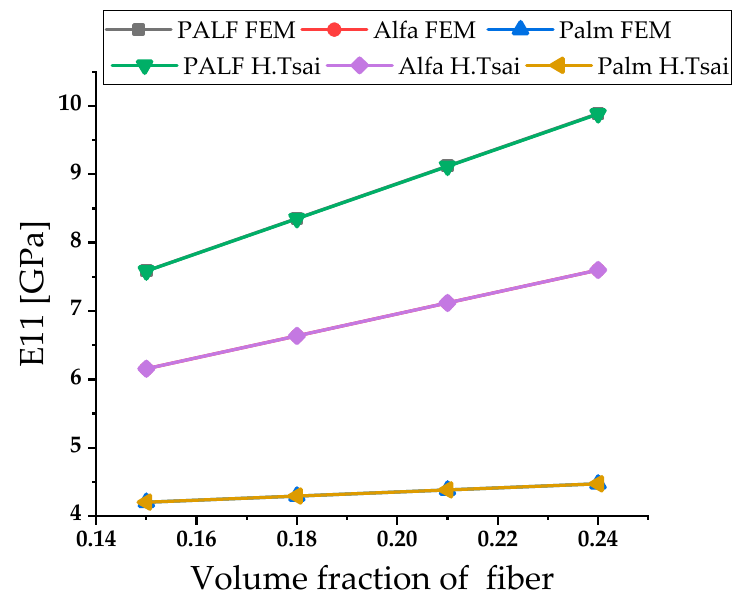
Figure 11. Predicted analytical (Halpin–Tsai model) and numerical results for E 11 in terms of V F . The FEM anticipated results are in good correlation with the analytical results. Figure 12 shows a comparison of the results obtained for 𝐸 (cid:2870)(cid:2870) using the FEM and the analytical analysis. The prediction of the transverse modulus show that the composite based on PALF fibers presents the best behavior in compression.